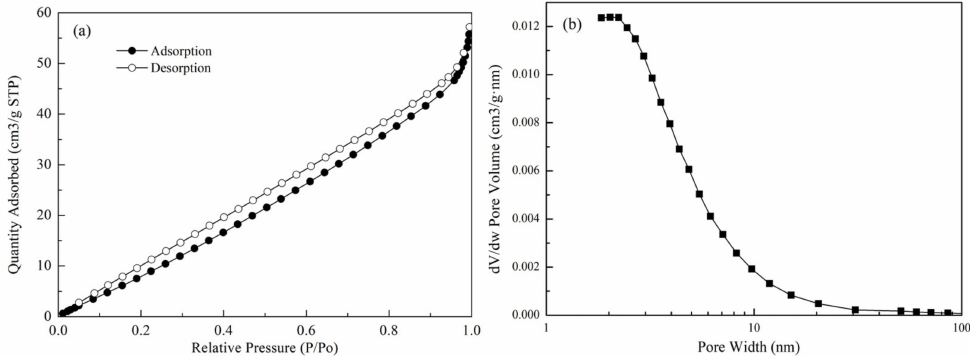
Figure 6. Adsorption desorption curve ( a ) and pore size distribution ( b ) of roasted product.